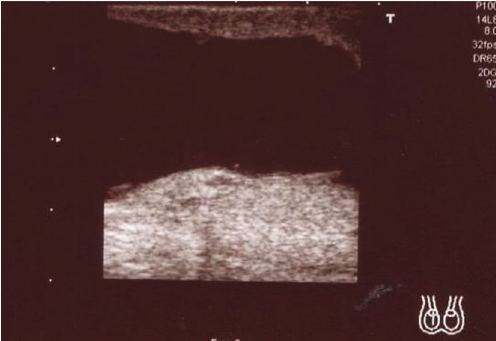
Figure 1: Scrotal ultrasonography image showing liquid component. Neoplastic lesions, normal testicle components, and the epididymis were not clearly visible.